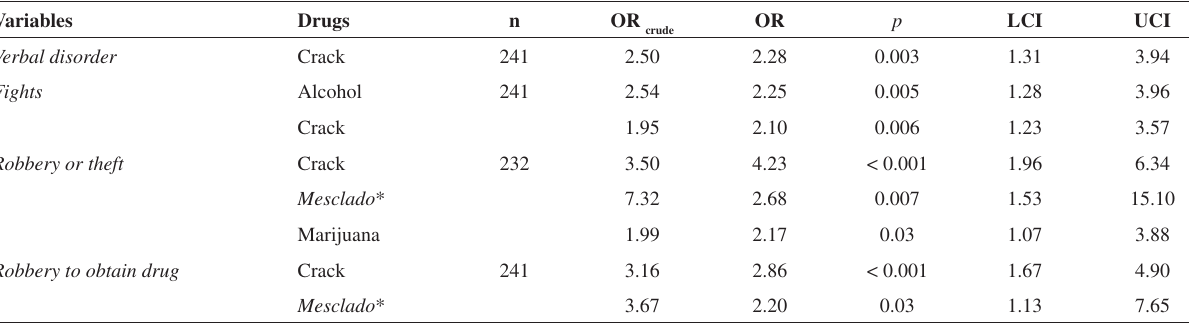
Table 5 - Four logistics analyses among violence variables and